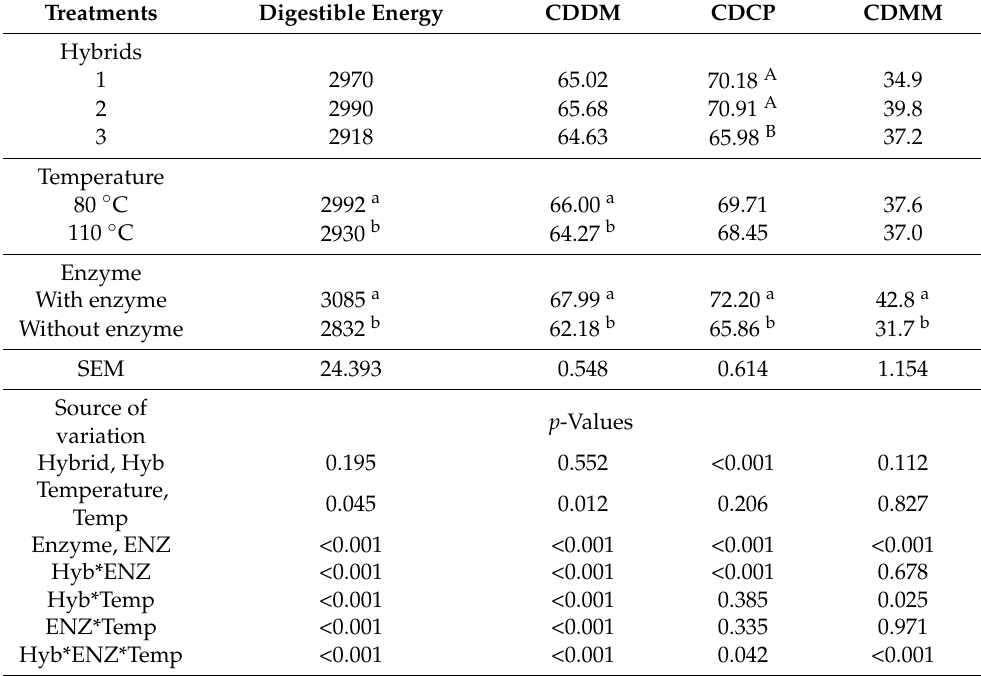
(Table S7). For hybrid 1, an increase of 4.23, 6.21, and 46.89% was observed for CDDM, CDCP, and CDMM, respectively, when enzymes were included in the diets formulated with corn dried at 110 ◦ C. Table 4. Average values of digestible energy (kcal/kg) and digestibility coefficients (%) of dry matter, crude protein and mineral matter determined in broilers fed diets containing different corn hybrids, dried at two temperatures, and with or without the inclusion of an enzymatic blend. Treatments Digestible Energy CDDM